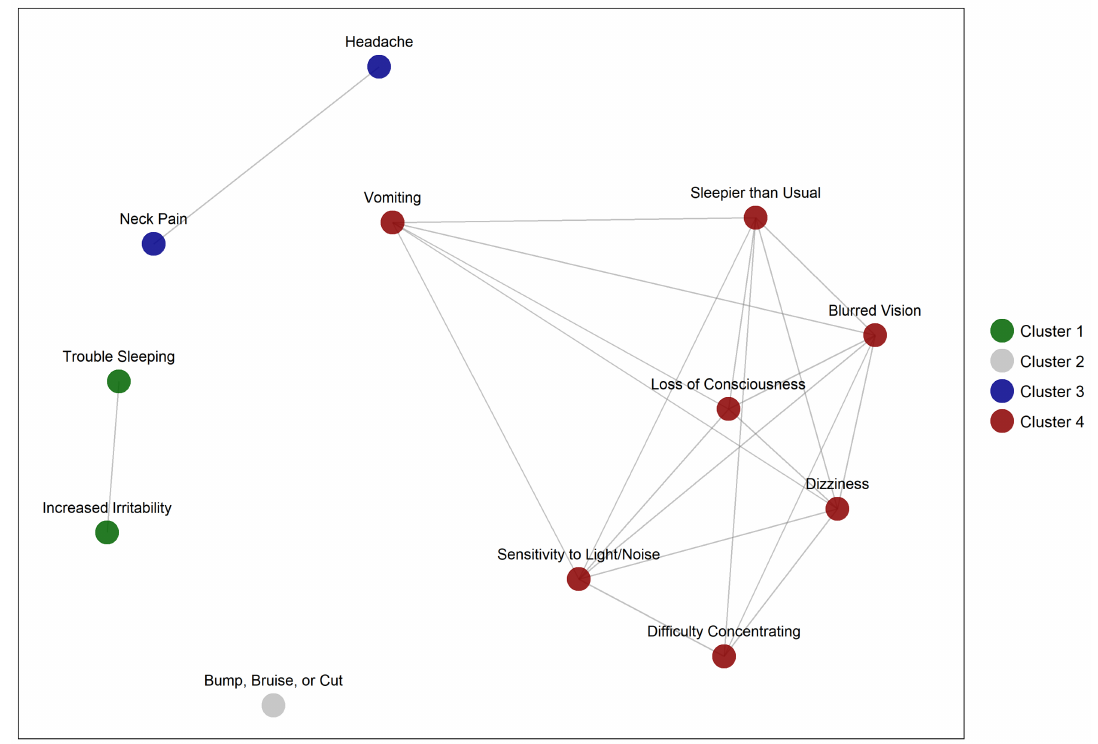
Figure 2. Clusters derived from community detection analysis. The clusters with each symptom’s mean intention score were: Cluster 1: Increased Irritability/More Emotional (2.6), Trouble Falling or Staying Asleep (2.9); Cluster 2: Bruise-Bump-Cut (2.9); Cluster 3: Headache (2.9), Neck Pain (3.1); Cluster 4: Difficulty Concentrating (3.4), Feeling Sleepier (3.4), Vomiting (3.5), Sensitivity to Light/Noise (3.6), Feeling Dizzy (3.6), Blurred Vision (3.8), Loss of Consciousness